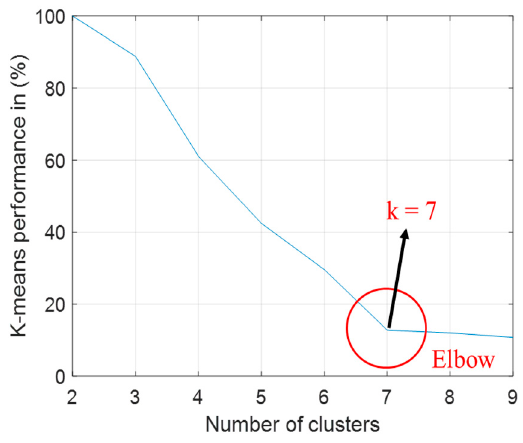
Figure 4. Example of a K-means performance curve to apply the elbow method.